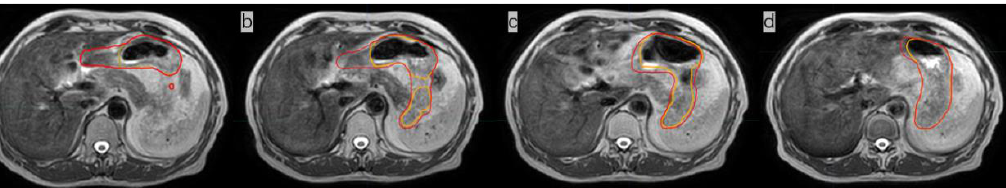
Figure 2. Comparison of images of the whole stomach on the same plane after the 1st, 5th, 10th, and 15th fractions, showing the radiation oncologist’s delineation (red line) and the delineation obtained with AI (orange line). The dice similarity coefficient (DSC) of the three-dimensional stomach images indicated by these four outlines are 0.8311 ( a ), 0.9185 ( b ), 0.9193 ( c ), and 0.9427 ( d ), respectively.